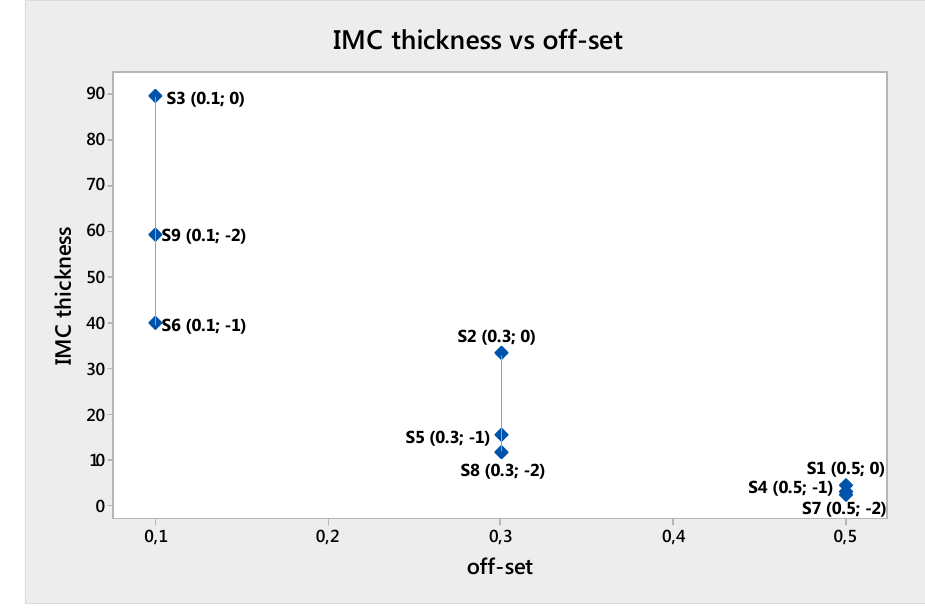
Figure 15. IMC versus off-set.